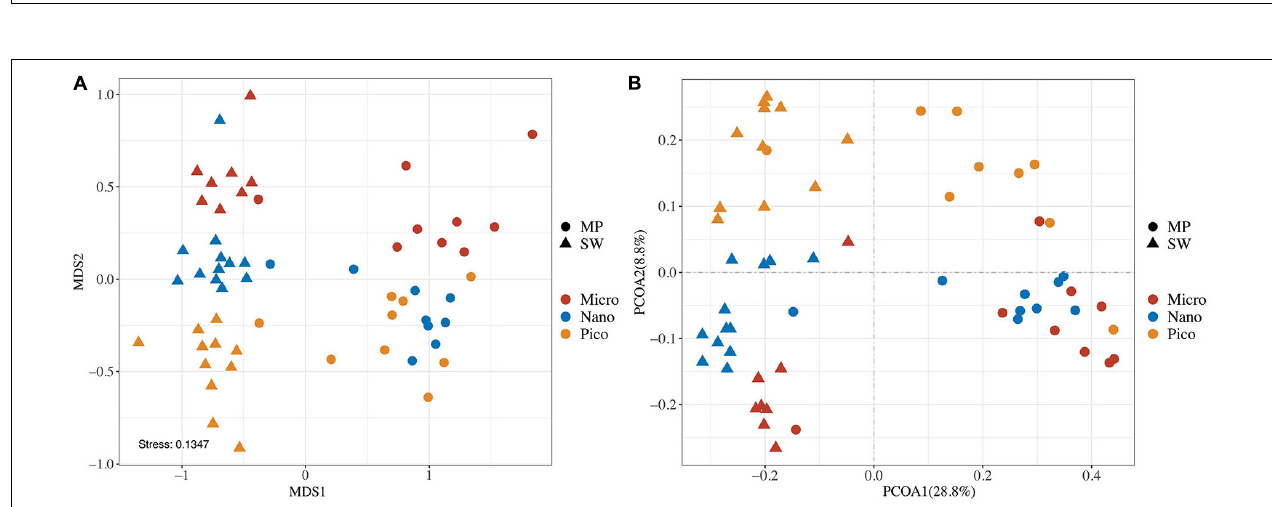
FIGURE 4 | Plots of non-metric multidimensional scaling (nMDS) ordination based on Bray Curtis dissimilarities (A) and Unweighted UniFrac principal coordinates analysis (PCoA; B ) of microbial eukaryotes based on community distance matrices.